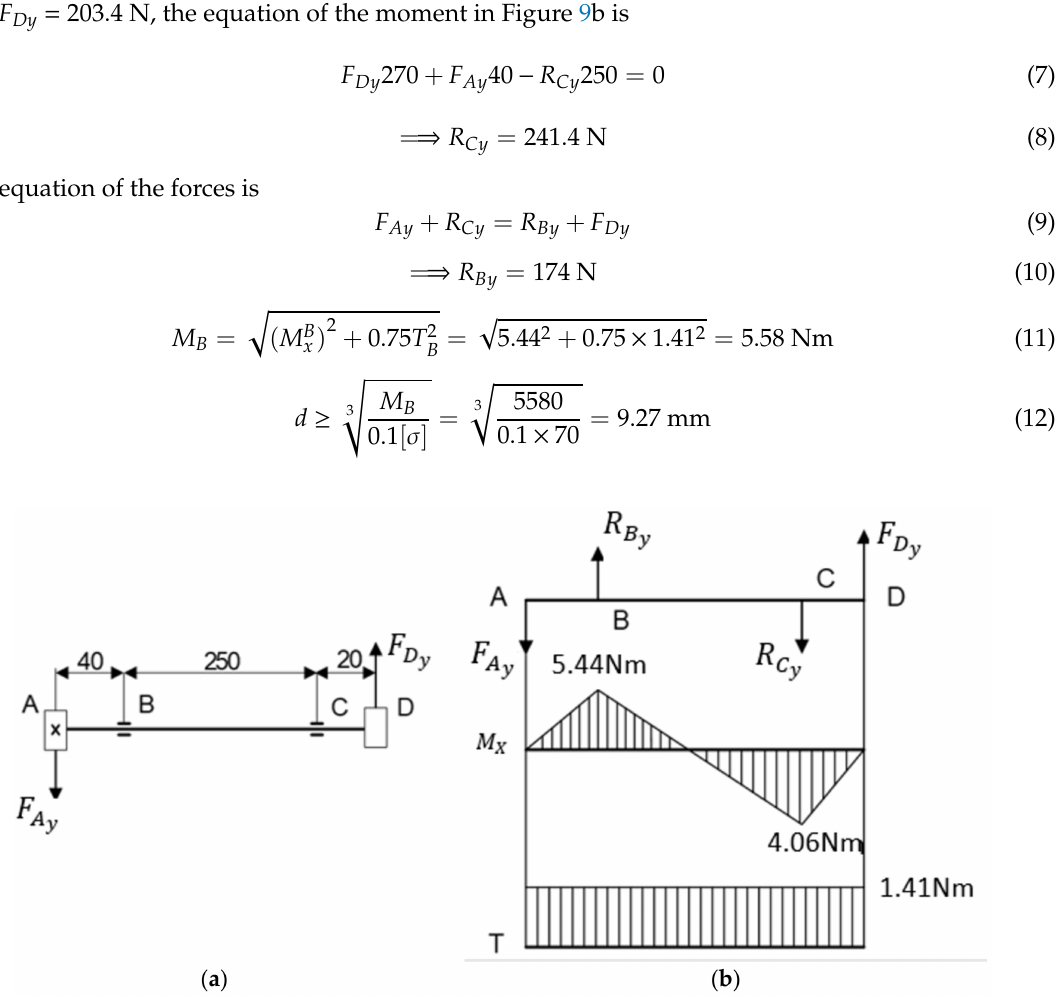
Figure 9. Analysis of joint 3: ( a ) model of forces, ( b ) distribution of